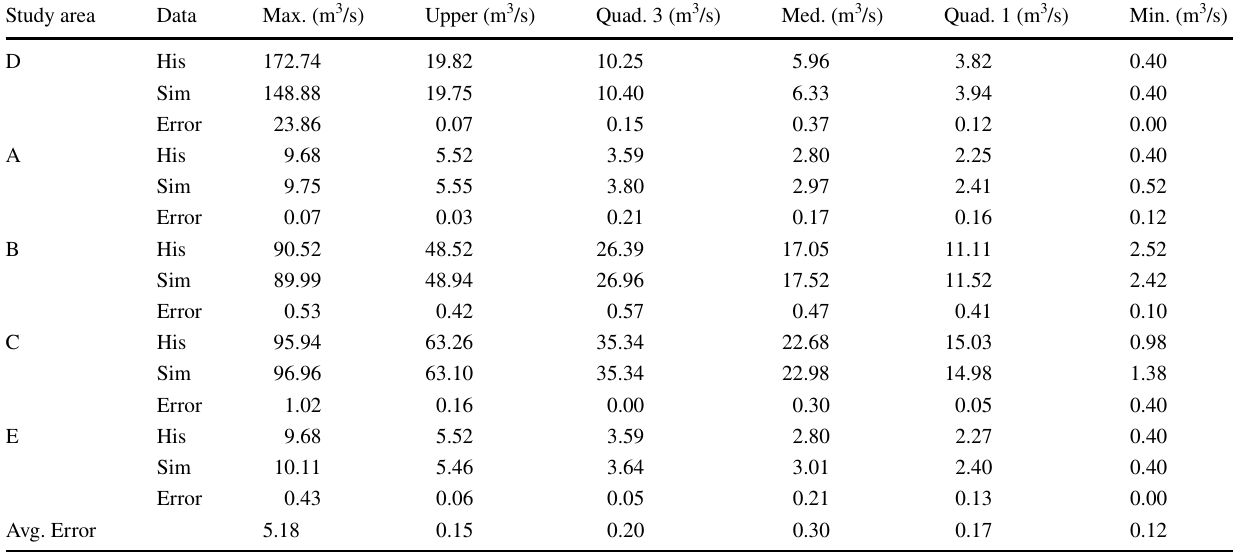
Table 8 Summary of violin plot at all five study areas